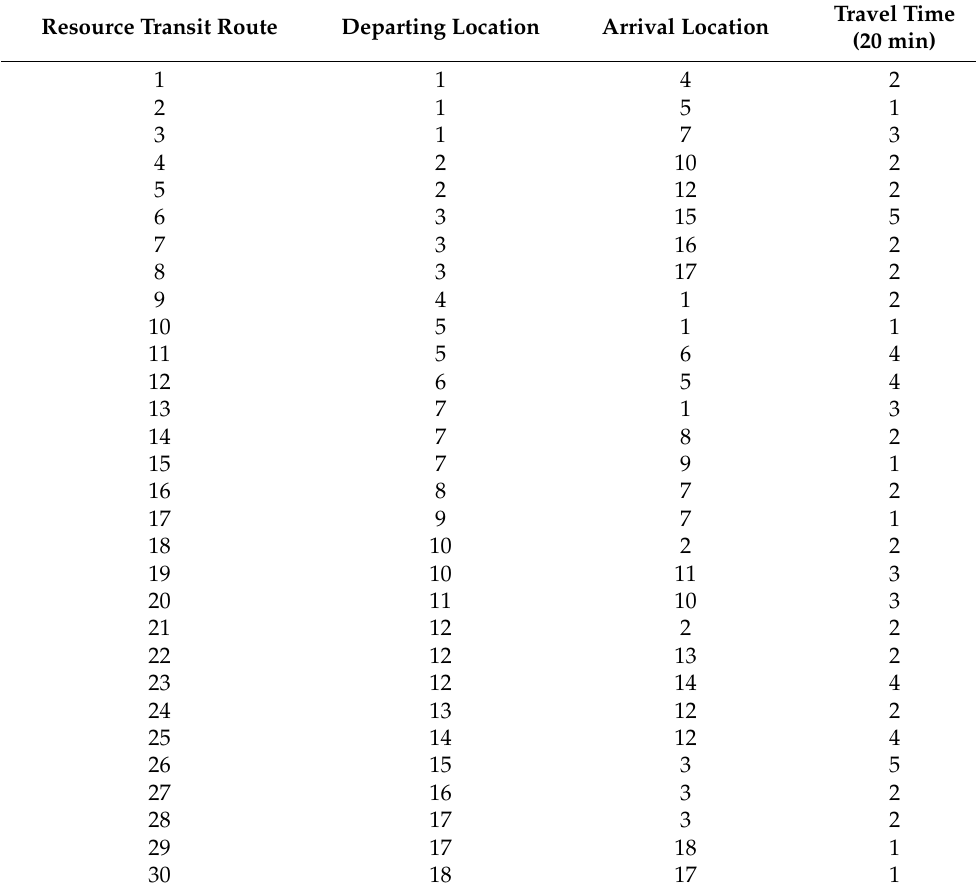
Table 4. Resource transit route and travel time (Case